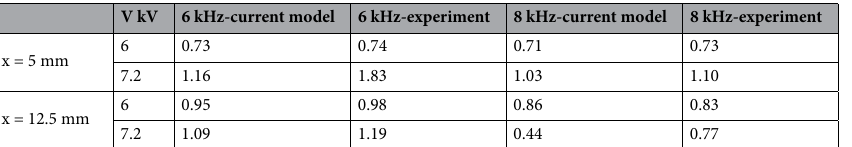
Table 3. The comparison of the calculated integrated horizontal body force component for different input voltages and the experimental